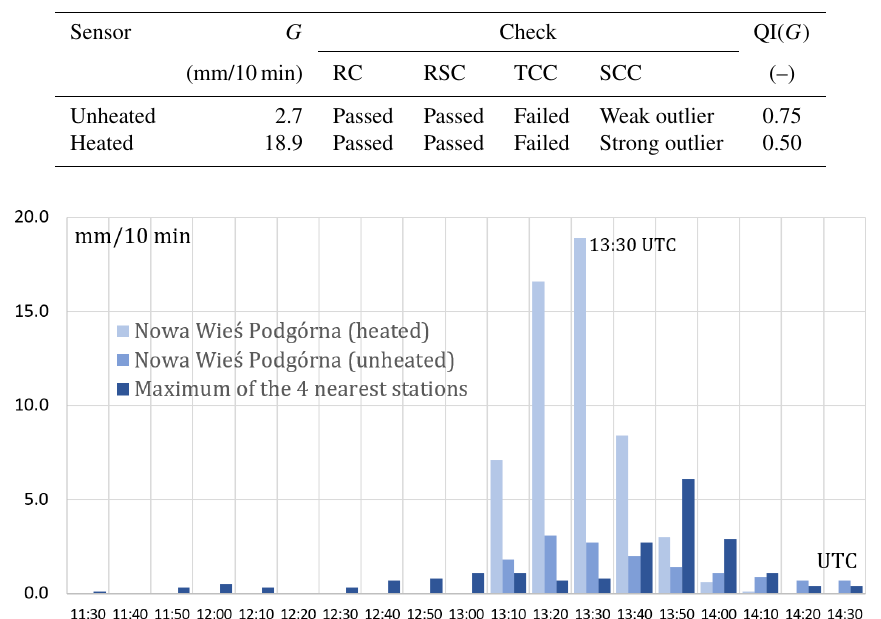
Figure 9. Precipitation time series at Nowa Wie´s Podgórna station in comparison to the maximum of four neighbouring rain stations on 22 June 2021 from 11:30 to